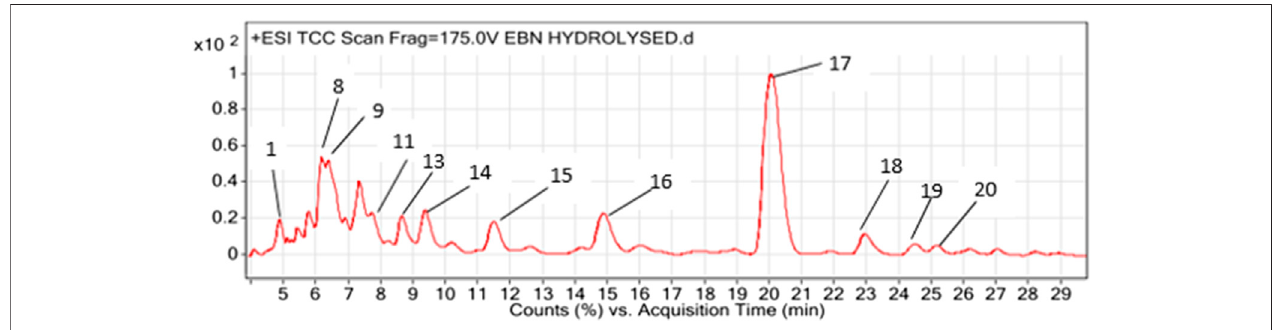
FIGURE 1 | LCMS chromatogram pro fi ling of hydrolyzed bird ’ s nest (HBN).